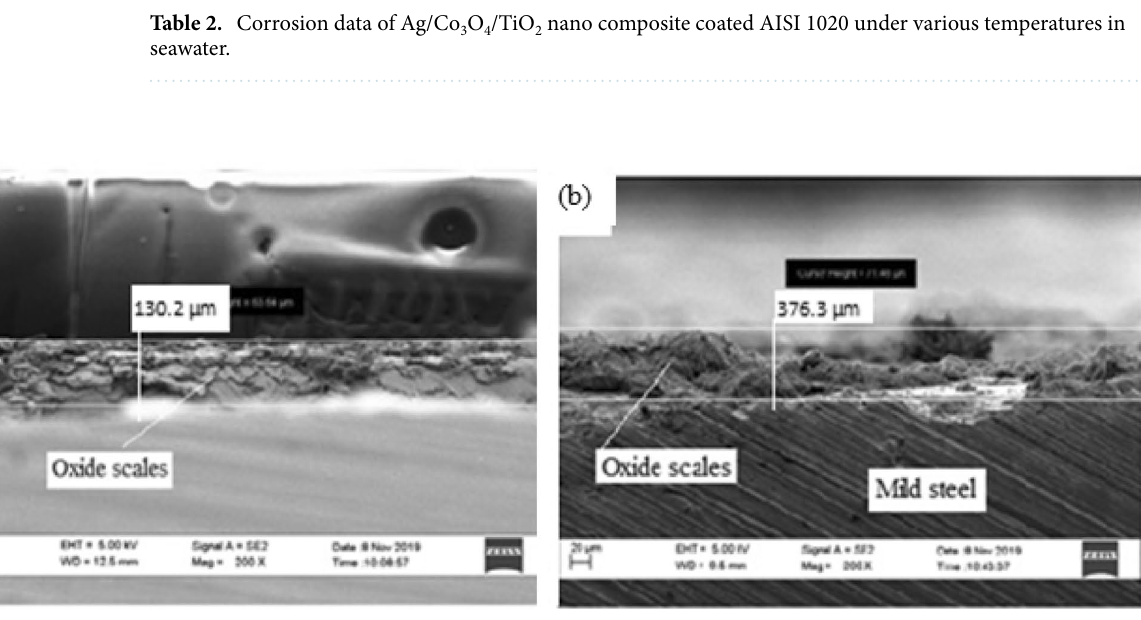
Table 2. Corrosion data of Ag/Co 3 O 4 /TiO 2 nano composite coated AISI 1020 under various temperatures in seawater.